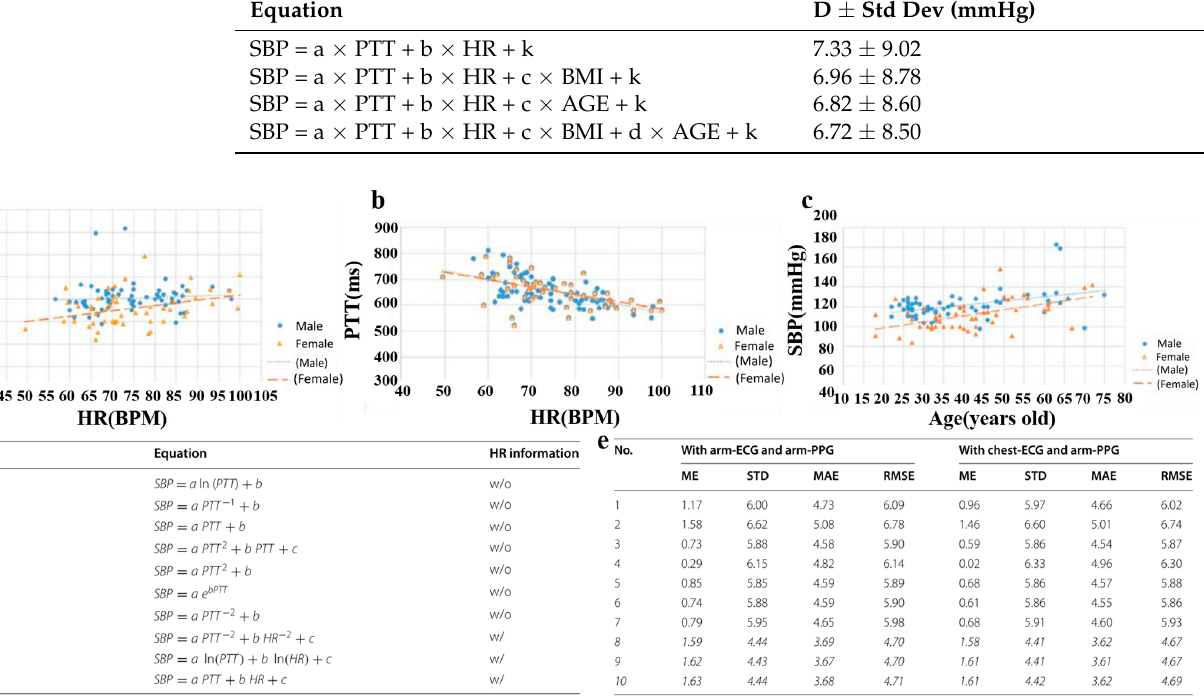
Table 1. Blood pressure estimation equations and errors for different parameter combinations [78]. Equation